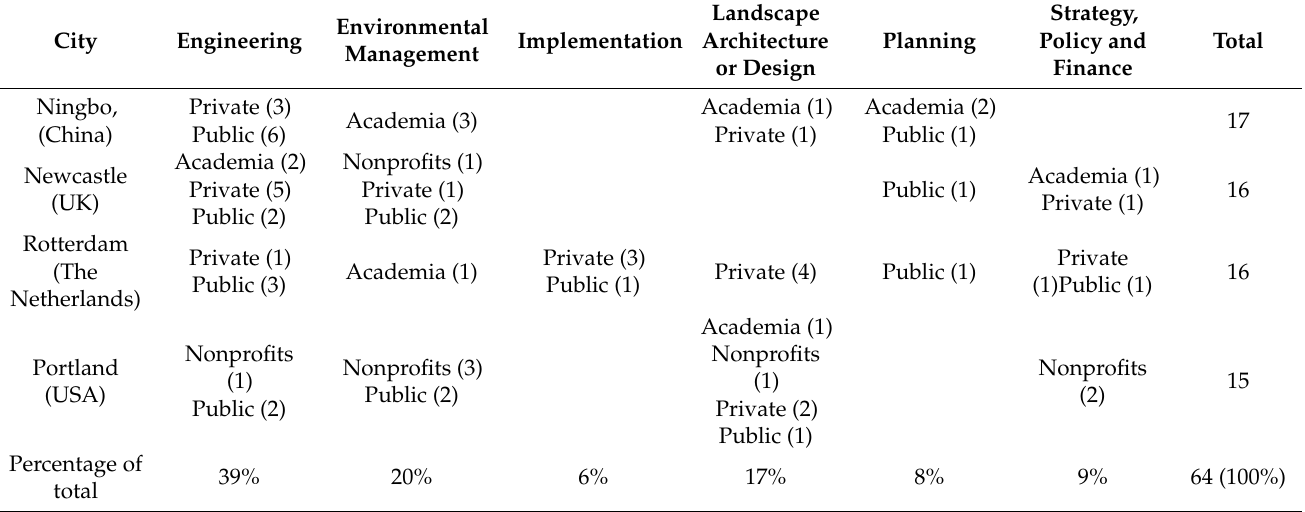
Table 2. Respondents’ discipline and type of organisation (those who completed all questions). ‘Public’ typically refers to government